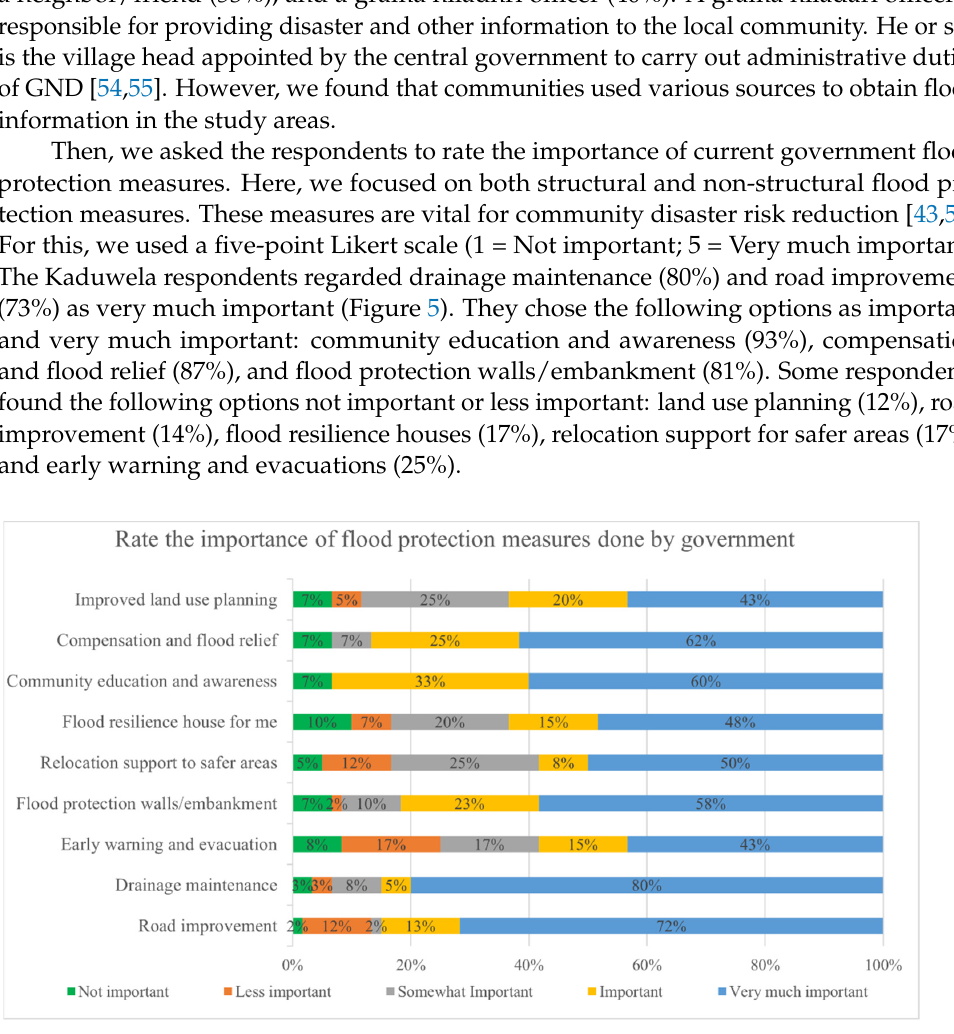
Figure 6. Importance of government flood protection measures in Kolonnawa. 3.4. Factors That Influenced Respondents’ Perceptions about Flood Experience After having these results, we attempted to identify factors that might have influ- enced the respondents’ perceptions. For this purpose, we conducted a multiple regression analysis (Table 2) by pairing the respondents’ perceptions about flood experiences with their age, gender, marital status, household size, education, average monthly income, housing structure, and housing type. We also added other independent variables such as